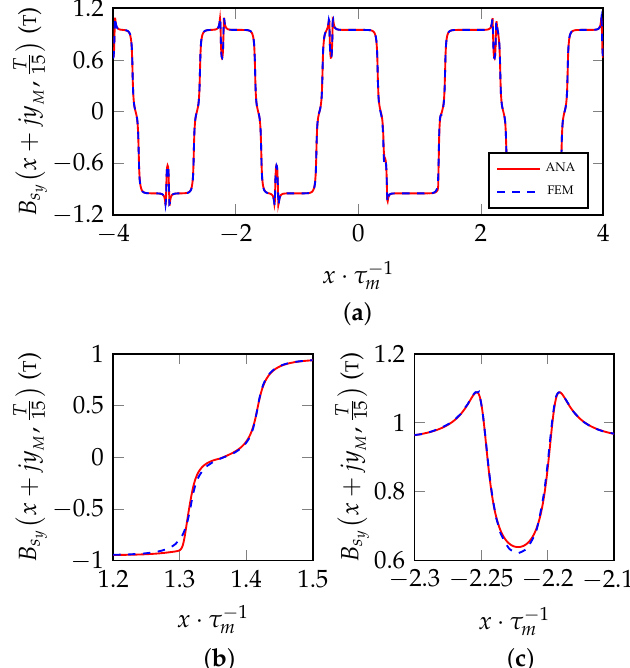
Figure 10. Analytical and FEM no-load flux density normal component on the middle mechanical air-gap line of the slotted machine of Figure 5a, with PM slider position corresponding to a time instant t = T/15 ( 4 τ m 4 τ m N x = 1000, N h = 150); ( b , c ) are two different selective zooms x − ≤ ≤ of ( a ).